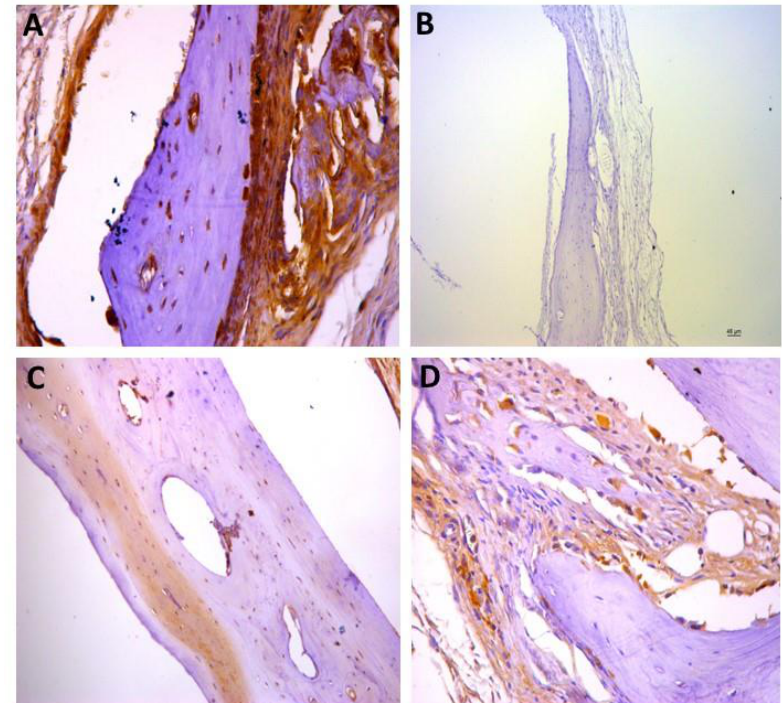
Figure 9. Representative immunohistochemistry images for osteopontin staining. ( A ) control group; ( B ) negative control; ( C ) group 2 with marking considered (++); ( D ) group 9 with marking consid- ered (++++); the most observed staining pattern among the groups analyzed. Harris’ hematoxylin counterstained. Scale bar: 46 µ